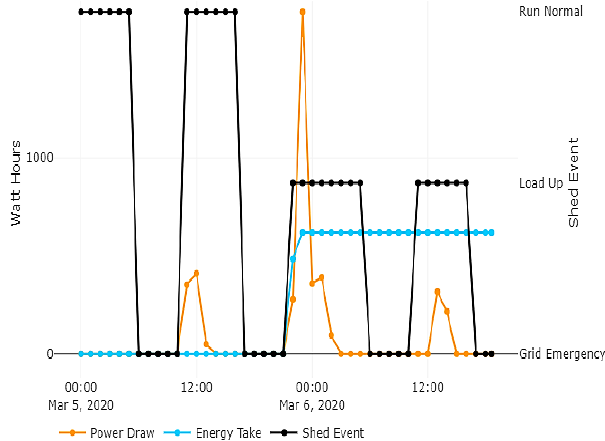
Figure 2. Manufacturer A HPWH behavior 5–6 March that led to a complaint.